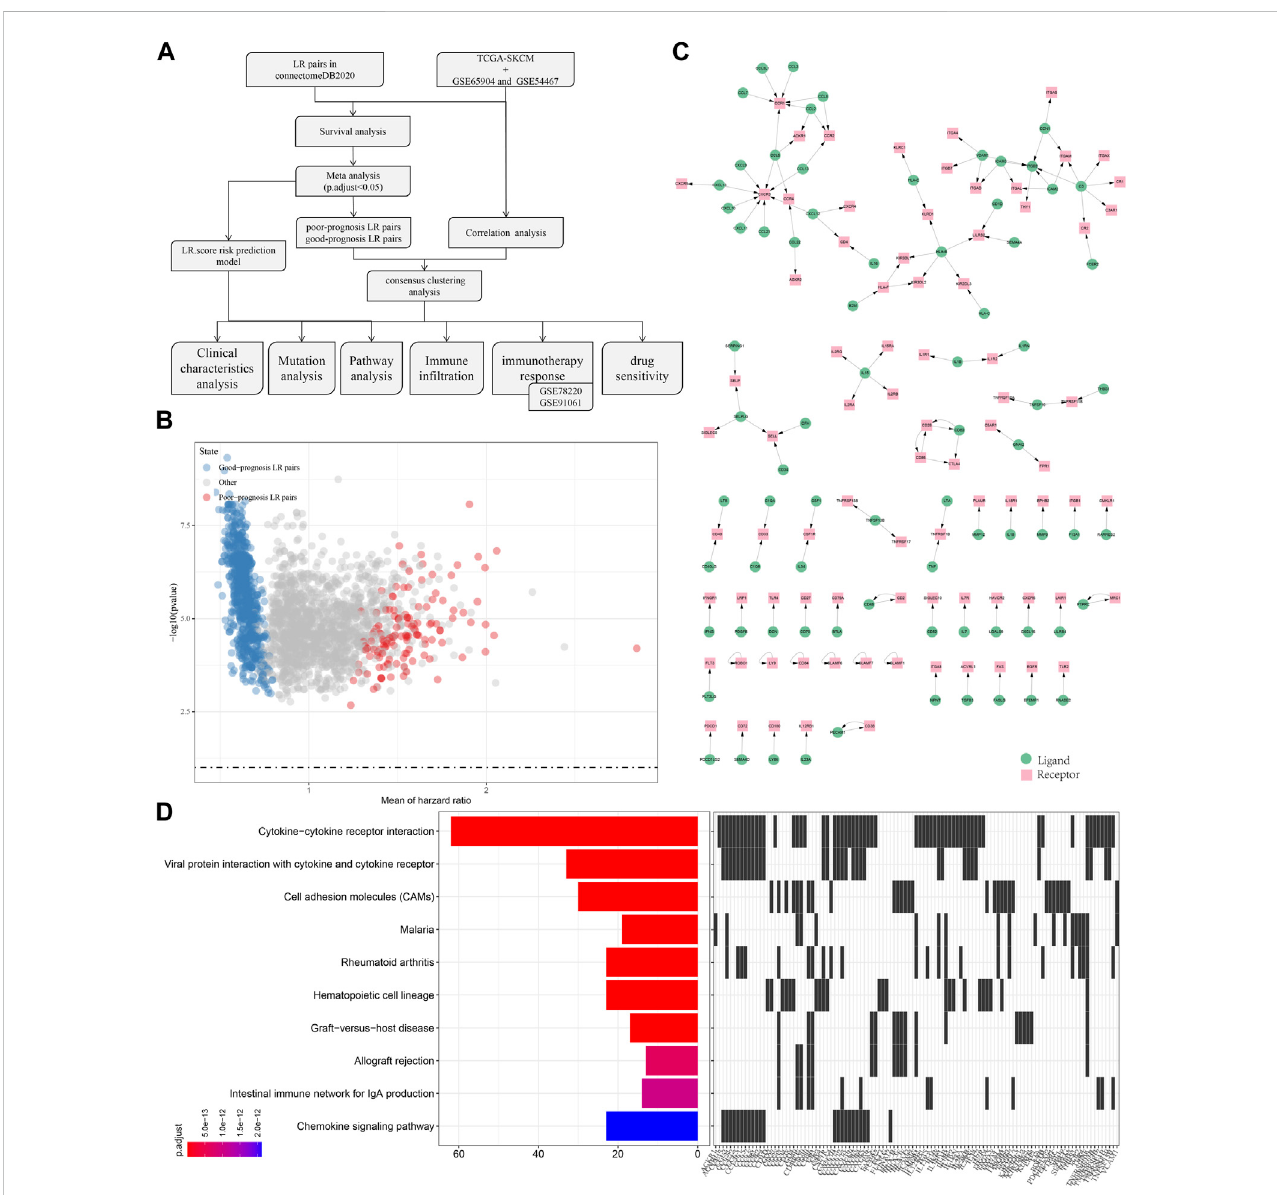
FIGURE 1 ScreenofLRpairsassociatedwithpatientprognosis. (A) Flowchartofthescreeningprocess. (B) VolcanoplotofLRpairs. (C) Interactionnetworkdiagram ofLRpairswithsigni fi cantprognosisandsigni fi cantlycorrelatedexpression. (D) Top10KEGGpathwayenrichmentresultsofLRpairswithsigni fi cantprognosis and signi fi cantly correlated